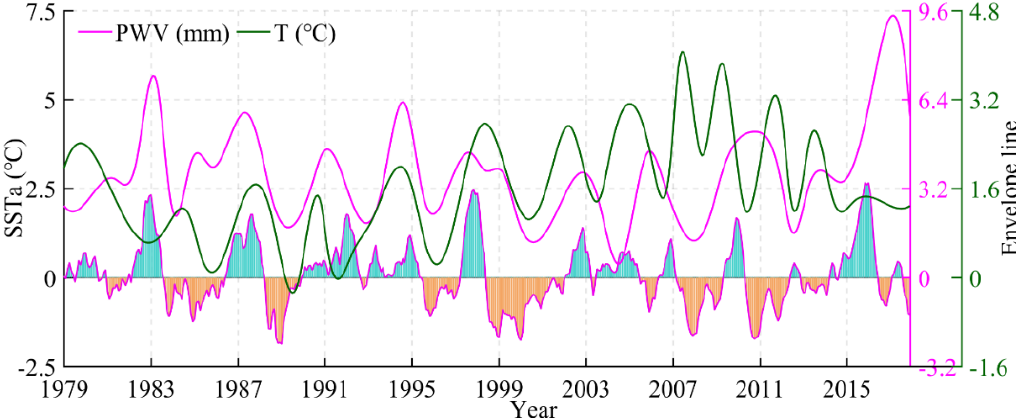
Figure 8. Envelope lines of PWV and T with SSTA over the period of 1979 – 2017 in Southeast China.